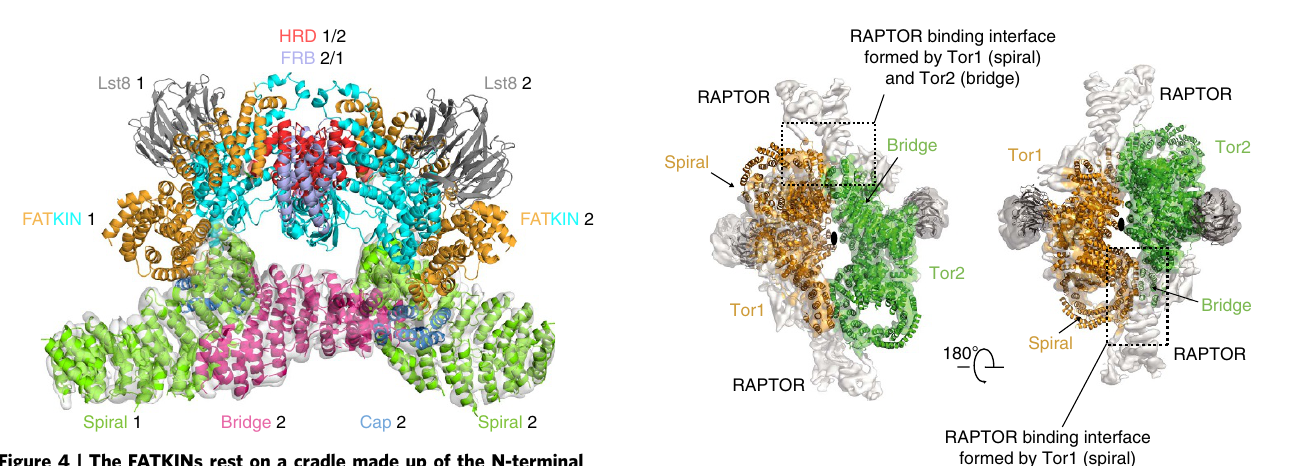
Figure 4 | The FATKINs rest on a cradle made up of the N-terminal solenoids. The spiral (green) and bridge (magenta) domains associate with each other in the dimer of KmTor–Lst8 heterodimers to form a cradle on which the FATKINs rest. KmTor–Lst8 cryo-EM density is shown for the N-terminal solenoid region that precedes the FATKIN. The HRD that forms the interface between the FATKINs in the dimer is colored red and the FRB is colored light purple. The cryo-EM density was contoured as in Fig. 3.